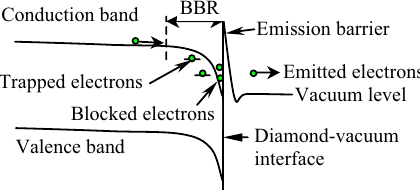
FIG. 2. Possible stopping mechanisms of electrons on the H surface during emission pulses. This band diagram does not include the effect of the external